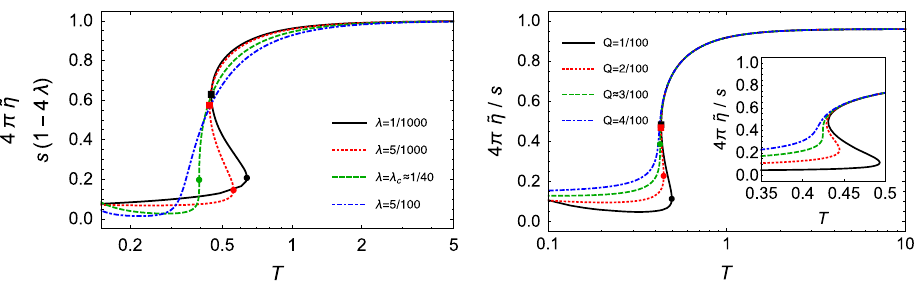
λ -dependent has been normalized to 1. Right panel : GB BHs with fixed value of GB constant λ = 1 / 100 and selected values of charge Q = 1 / 100 , 2 / 100 , ∼ 3 / 100 , 4 / 100. Inset: zoom of the hysteresis region. Dots (squares) mark the local maximum T max (local minimum T min ) of the temperature